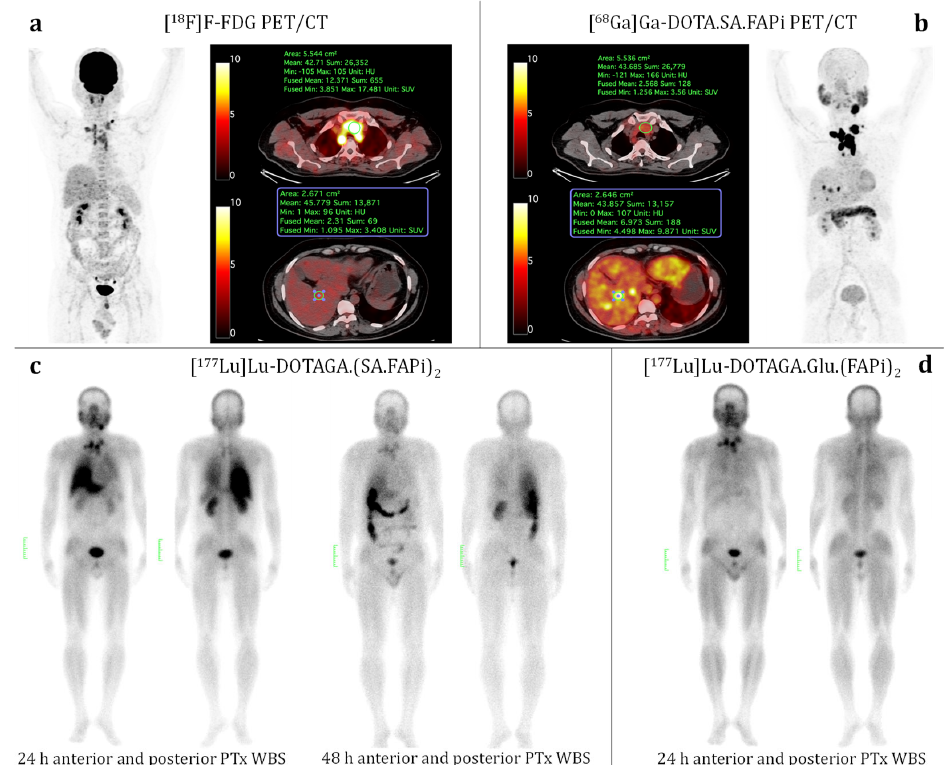
Figure 9. A 40 ‐ year ‐ old male diagnosed with medullary thyroid carcinoma underwent [ 18 F]F ‐ FDG PET/CT scan ( a ) followed by [ 68 Ga]Ga ‐ DOTA.SA.FAPi PET/CT scan ( b ) with the scale being SUV in PET/CT scan ( a ) followed by [ 68 Ga]Ga-DOTA.SA.FAPi PET/CT scan ( b ) with the scale being %ID/g. The patient underwent two cycles of 5.5 GBq of [ 177 Lu]Lu ‐ DOTAGA.(SA.FAPi) 2 therapy ( c ). The post ‐ treatment whole ‐ body scan at 24 h p.i. ( c , left ) reveals intense uptake in the neck and